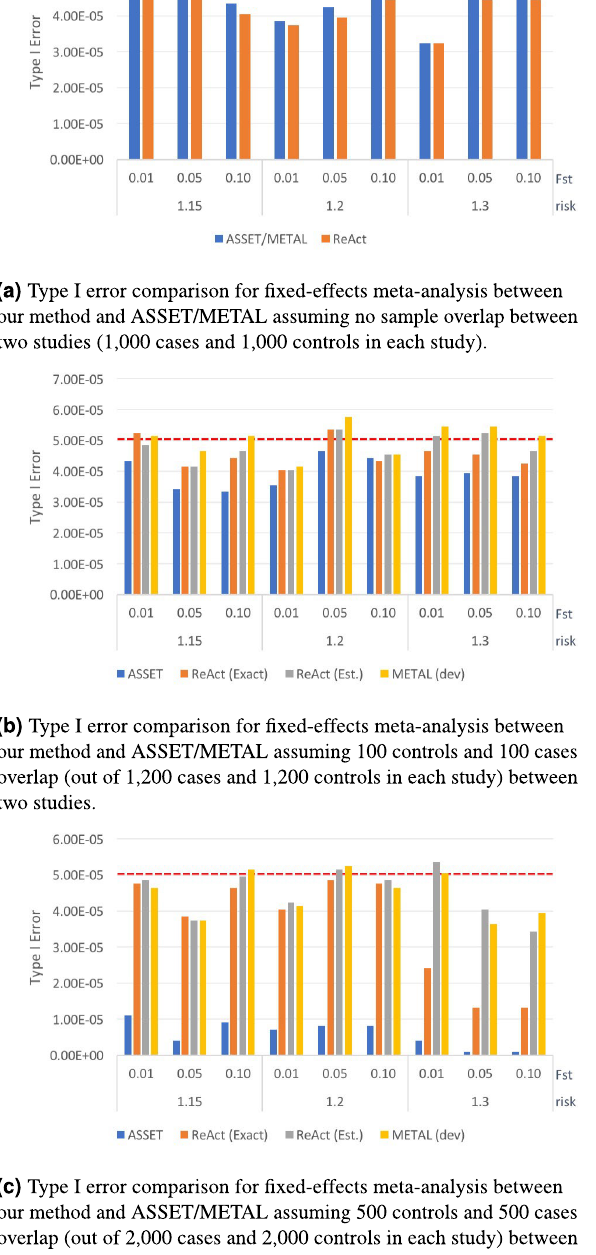
Figure 2. Type I error rate of fixed-effect meta-analysis with two input studies under different conditions. We compared the type I error rate of our method vs. ASSET/METAL for a significance threshold p < 5